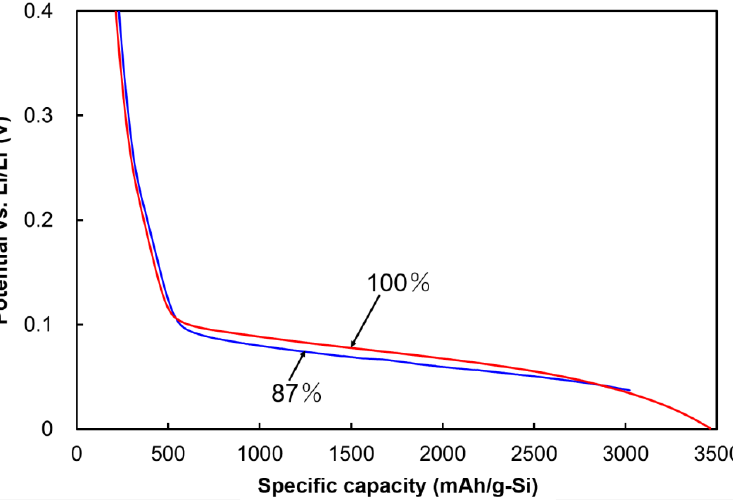
Figure 1. Potential variations of the Si anodes during the prelithiation processes of the 100% and 87% prelithiation